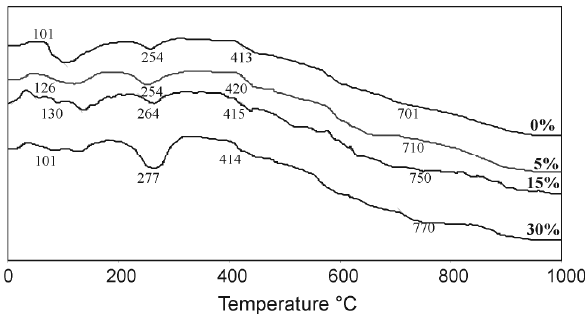
Fig. 9. DTA thermograms of cement pastes containing the percentage of